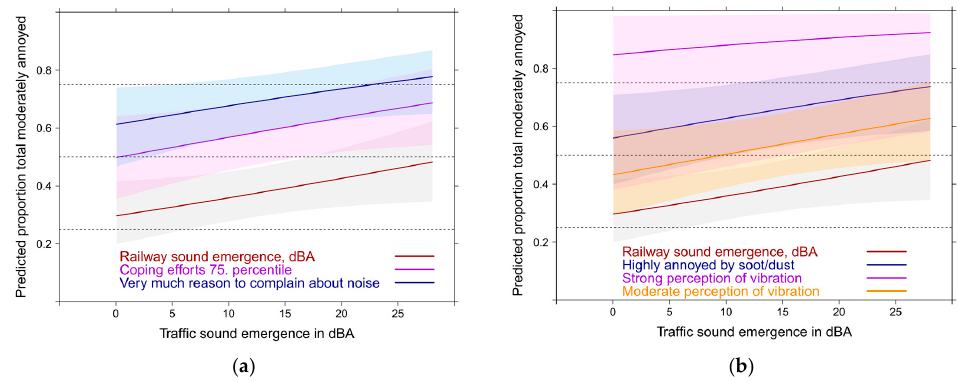
Figure 21. Predicted proportion of total moderate annoyance associated with the emergent sound from railways. ( a ) Proportion highly annoyed associated with the acoustic source indicators; ( b ) Proportion moderately annoyed associated with the acoustic source indicators; Depending on the predictors shown, adjusted for other predictors not shown in the graph (complaints about community soundscape and air pollution, perceived vibration (not ( b ), perceived dust/soot from road (not ( b ), coping not ( a ), anger at traffic load).